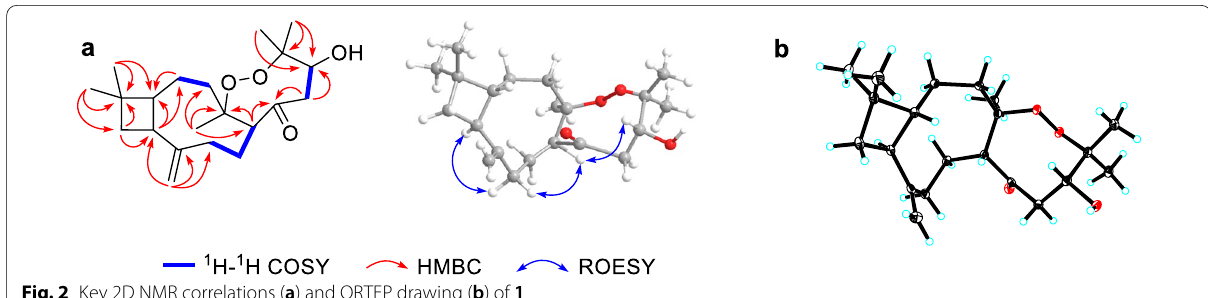
Fig. 2 Key 2D NMR correlations ( a ) and ORTEP drawing ( b ) of